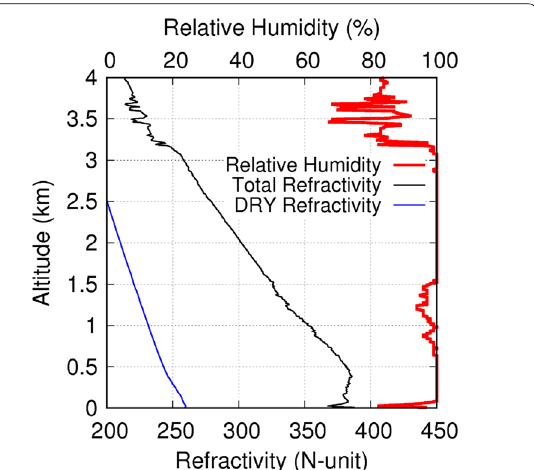
Fig. 10 Profiles of the refractivity and relative humidity observed by the radiosonde observation launched at 2331 UTC on June 10, 2017. The dry refractivity represents the first term on the right-hand side of Eq. vapor causes surface ducting and might lead to the large negative bias in the GNSS PWV. Figure 11 represents the frequency of the refractivity inversion layer top height observed by the RYOFU MARU radiosonde during the period of six years from 2012 to 2017. The inversion top height is defined as the height at which maximum refrac- tivity was observed from each radiosonde profile. Only